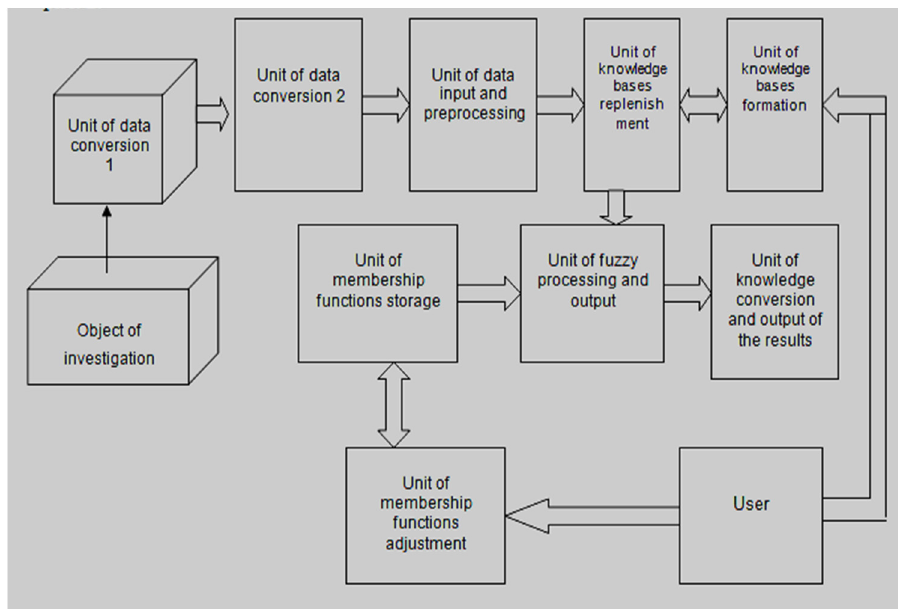
Figure 2. Architecture of the medical expert system.